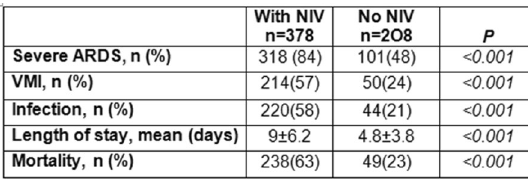
Table 1: Outcome comparison according to non-invasive